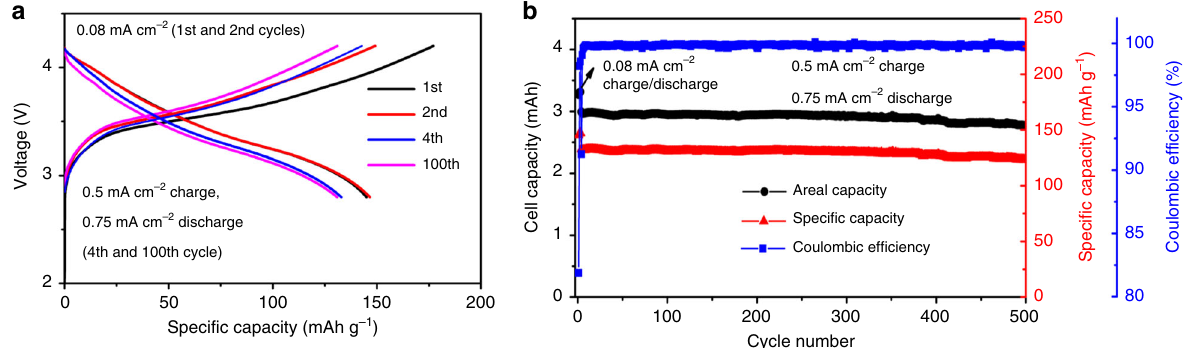
Fig. 5 Electrochemical performance of a typical full cell with Li(Ni 1/3 Mn 1/3 Co 1/3 )O 2 cathode and pre-cycled CNT@Si@C and graphite composite anode. a Voltage pro fi les. b Long-term cycling data of the full cell in